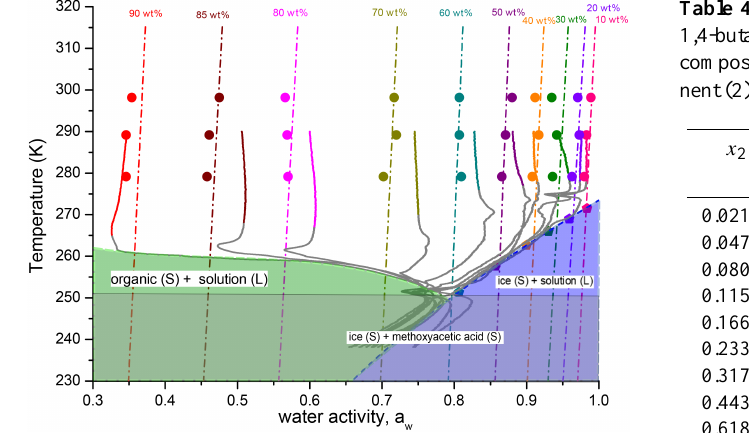
Figure 3. Measured water activities of aqueous methoxyacetic acid solutions vs. temperature. The different colours indicate the solution compositions in wt% of the organic component. The solid curves show data derived from the total gas phase pressure measurements. The coloured portion of the solid curves represents the temperature range for which the measurements are considered reliable within the uncertainty of the method ( ± 0.03 of a w ). Water activities de- rived from DSC measurements on the ice melting curve are repre- sented by pentagons. Bulk a w measurements using the water ac- tivity meter are represented by solid circles. The dash-dotted lines show the composition- and temperature-dependent a w parameteri- sation by Zobrist et al. (2008). The blue dashed line is the ice melt- ing curve (Koop and Zobrist, 2009). In the colour-shaded regions one or both components are supersaturated with respect to the solid phase and therefore, above the eutectic temperature ( ∼ 251K), at equilibrium one solid phase coexists with the remaining solution.